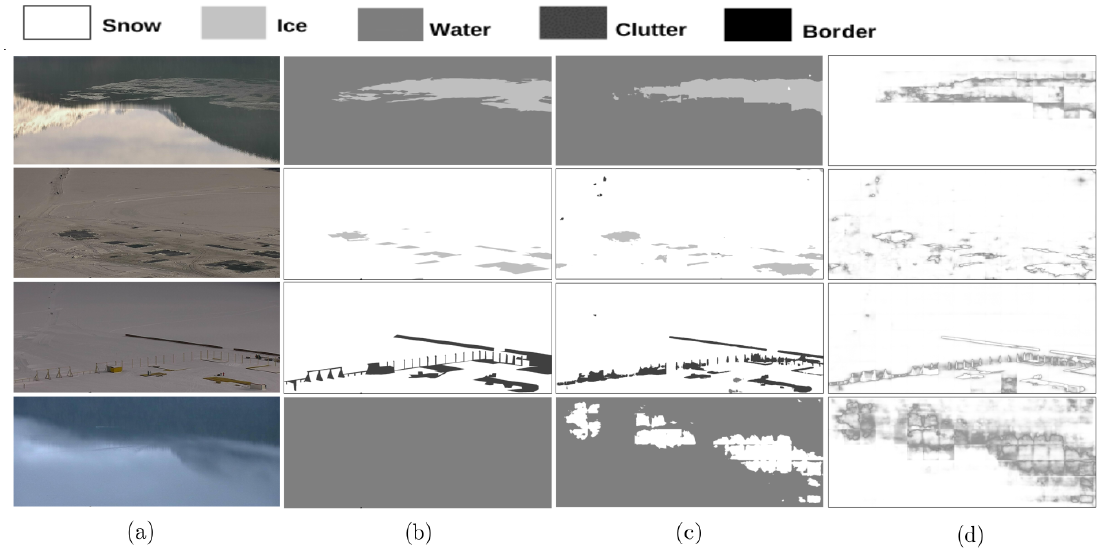
Figure 7. Semantic Segmentations for Cam1. (a): RGB input; (b): manual segmentations; (c): predicted segmentations; (d): reliability